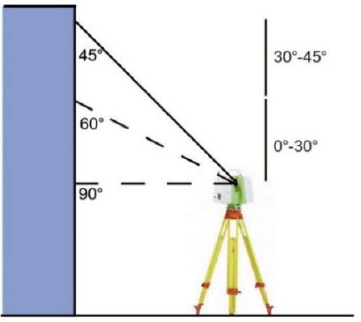
Figure 7. Optimal ranges of laser beam inclination between the object and the scanner. In particular, the ideal range is between 0 and 30 degrees – graphic elaboration by Maria Chiara Pugliese